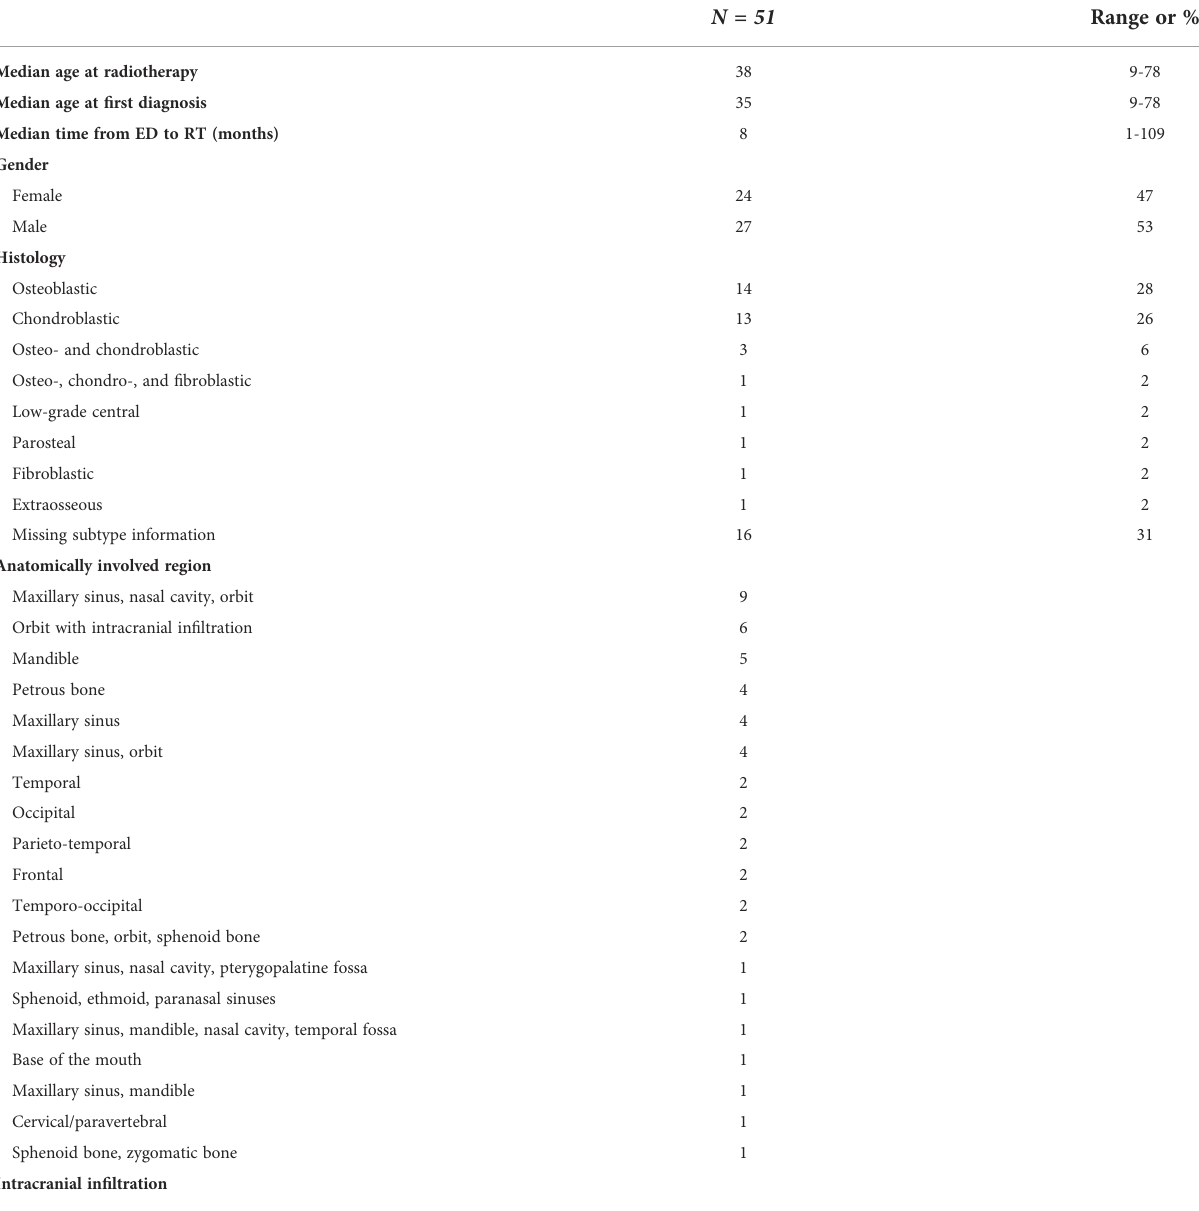
TABLE 1 Patient